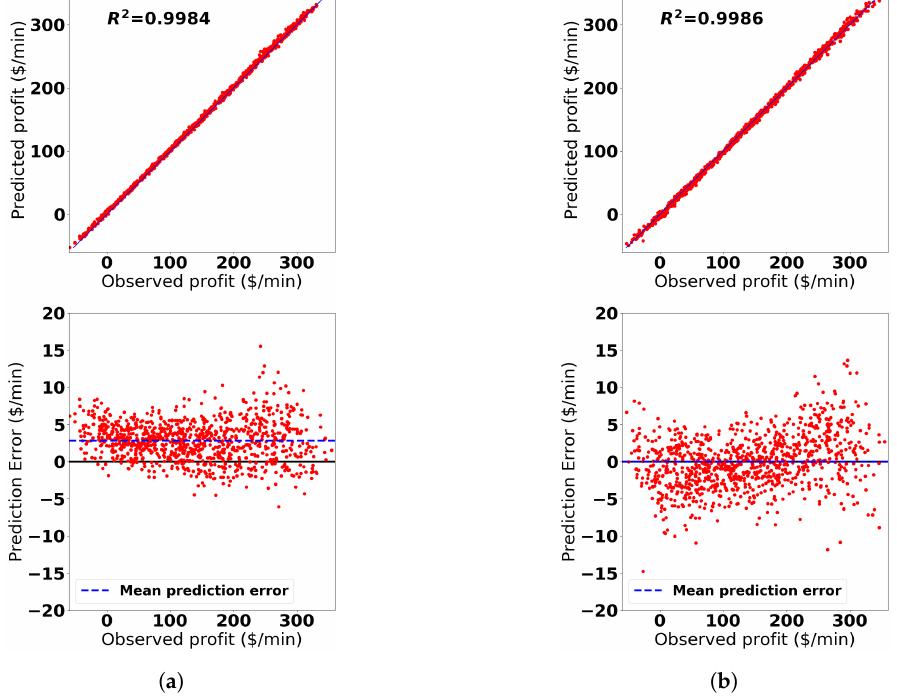
Figure 5. Parity plots (Row 1) and residual plots (Row 2) for ANN-PSO and Proximal Policy Optimization (PPO) value functions. ( a ) ANN-PSO action-value function; ( b ) PPO value function.